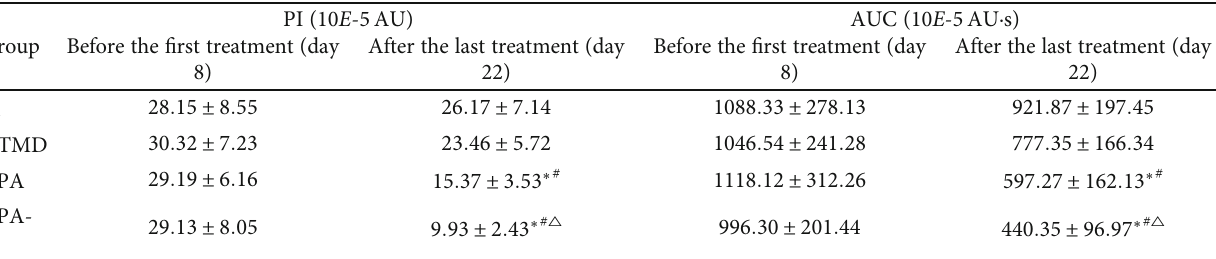
Figure 2: The tumor growth curve in di ff erent groups. Table 2: CEUS parameters in di ff erent groups ( n = 10 , (cid:1) x ± SD ).